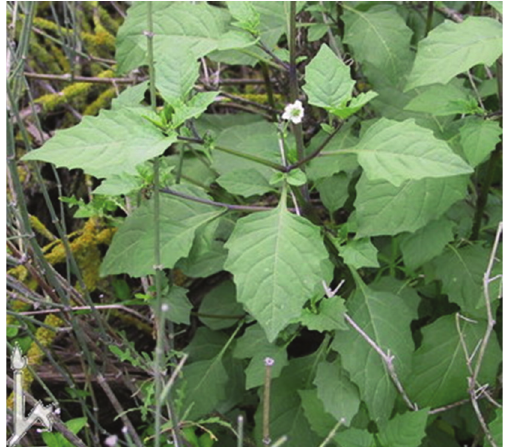
Figure 3: S. sinaicum